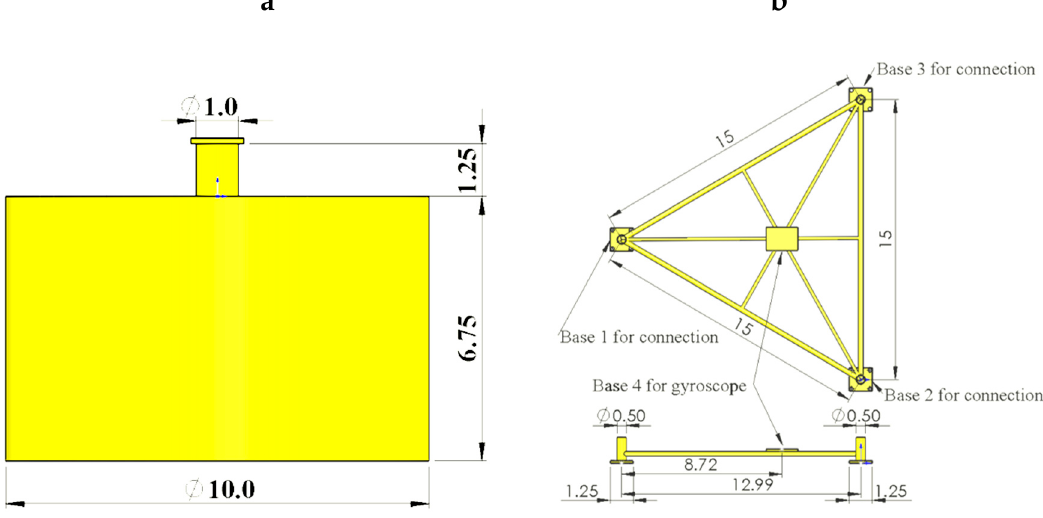
Figure 6. The prototype of the bucket foundation structure: ( a ) bucket foundation, ( b ) connecting frame.